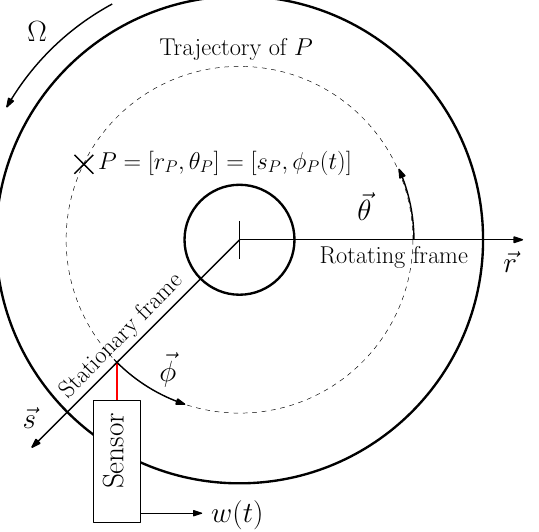
Figure 1. Sketch of a disk, rotating with Ω , and a sensor, fixed to stationary frame. Under the assumption of no eccentricity, the trajectory of a Point P on the disk is a circle so that only the angle φ p is time dependent at Ω > 0 Hz.